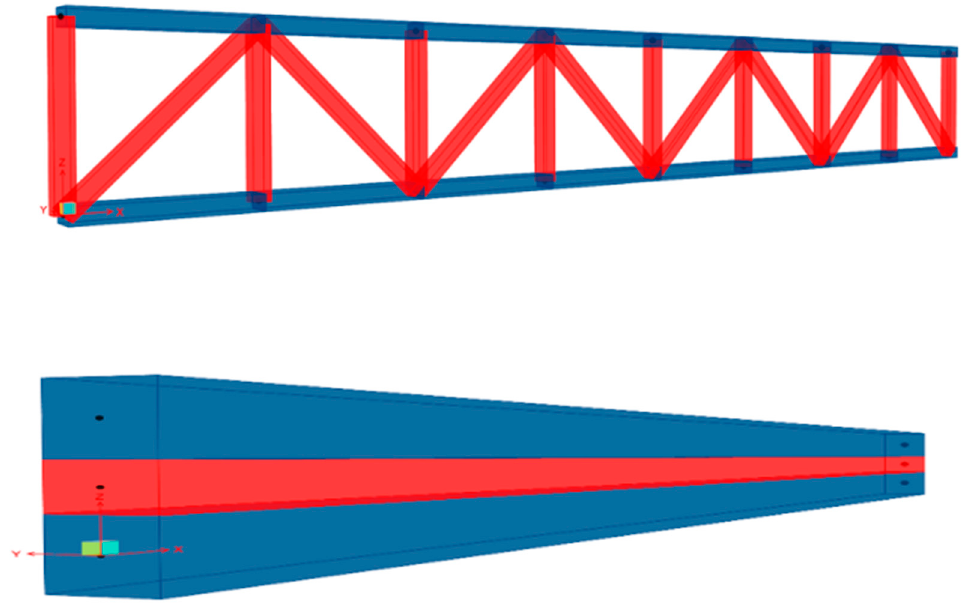
Figure 1. Simplification of truss structure to beam.